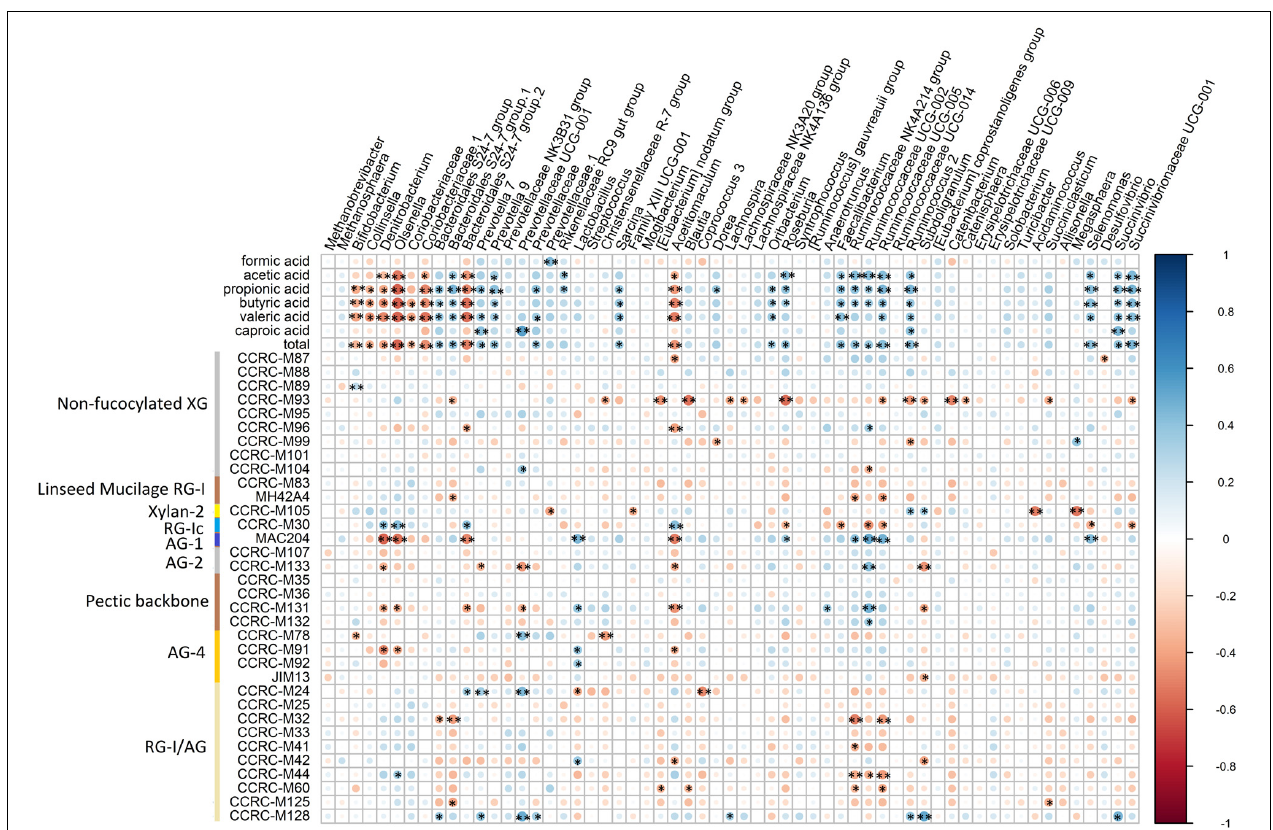
FIGURE 7 | Correlation between core bacterial genera, and SCFA and binding of mAbs. Statistical significance was determined for all pairwise comparisons using Pearson’s method. * P < 0.05; ** P < 0.01. Size of the circles indicates correlation strength, which bigger sizes meaning higher correlations. Blue circles represent positive correlations (correlation coefficients from 0 to 1), whereas red circles represent negative correlations (correlation coefficients from 0 to –1). total, total SCFA production. The mAbs are grouped based on the cell wall glycans they predominantly recognize as shown in the panel on the left-hand side of the figure. XG, xyloglucan; RG-I, rhamnogalacturonan I; AG, arabinogalactan; RG-I/AG, arabinogalactan side chains of